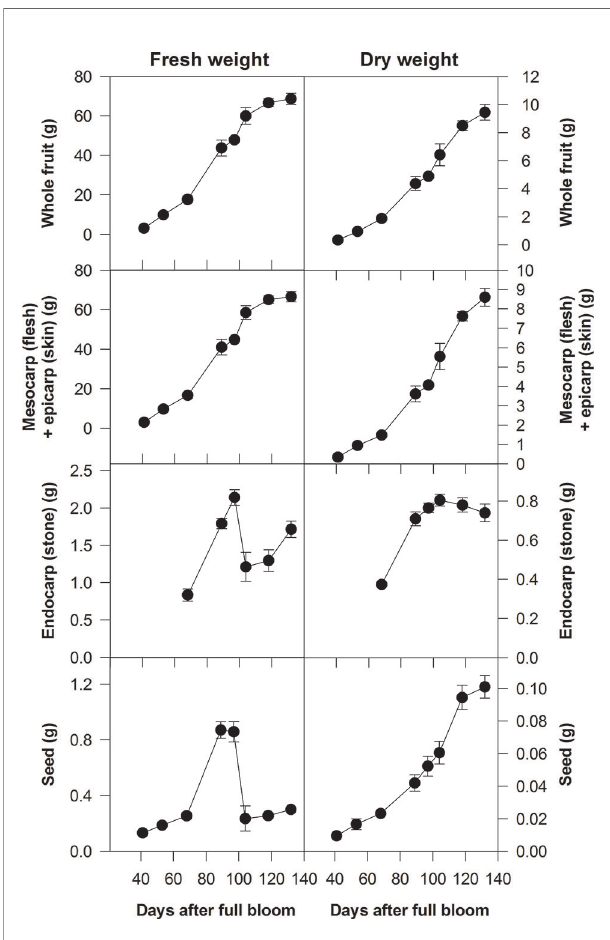
FIGURE 2 | Fresh and dry weights of whole fruits of Ozark Premier plum and their component parts at different stages of development (from Famiani et al., 2012). Based on changes in their fresh weight, the growth patterns of whole fruits and their fl esh plus skin were double sigmoidal: stage I was up to about 90 days after full bloom (DAB), stage III was after 100 DAB and stage II was between about 90 and 100 DAB. Bars represent the standard errors (n =